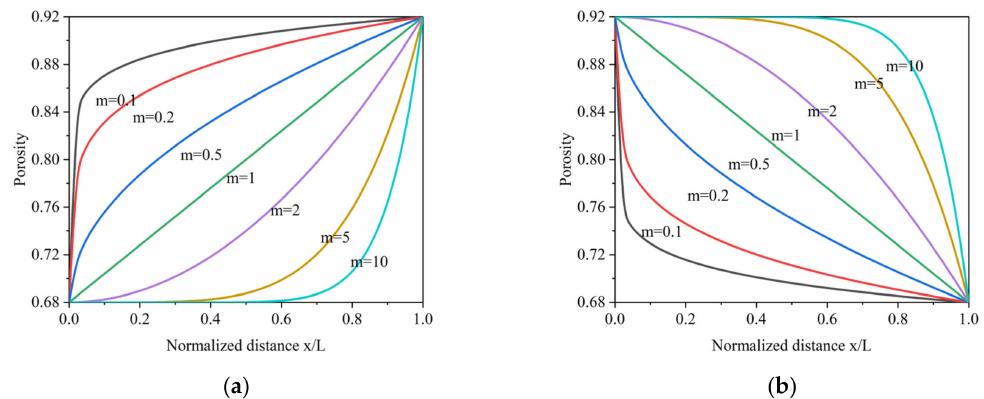
Figure 10. Variation of porosity gradient versus normalised distance: ( a ) porosity-increasing gradient pattern, ( b ) porosity-decreasing gradient